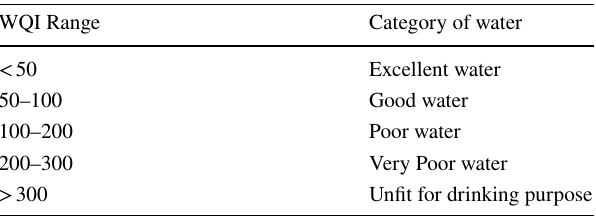
Table 3 Classification of WQI range and category of water (Tiwari et al.